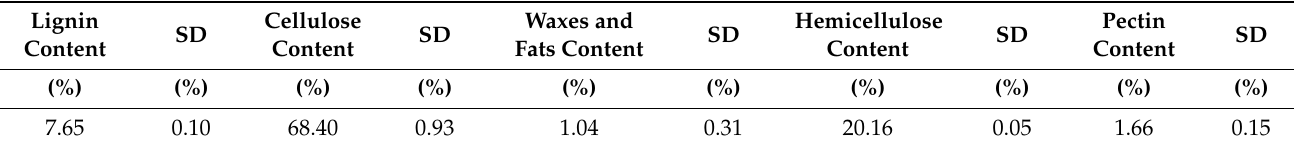
Table 2. Chemical composition of hemp long